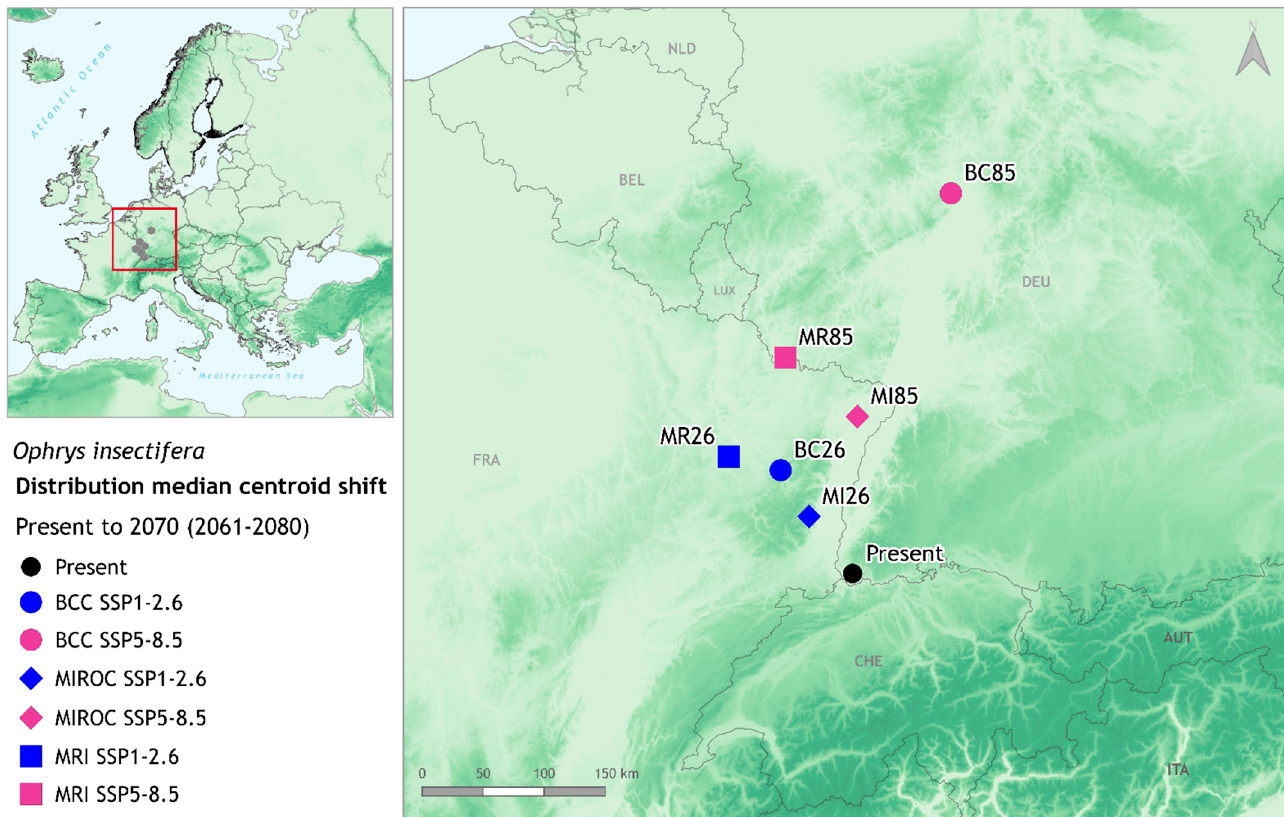
Figure 4. Median centroids for current and future projected distributions of Ophrys insectifera , for the EnvThin ensemble in 2070 time slice. Black point represents the current distribution’s median centroid, the blue points stand for the future best-case scenario (SSP1-2.6), and the magenta points for the future worst-case scenario (SSP5-8.5). GCMs differentiate by shape: BCC—circle, MIROC— diamond, MRI—square. Map is designed in QGIS v.3.18 ‘Zürich’, using ETRS89—Lambert Conformal Conic Coordinate Reference System.